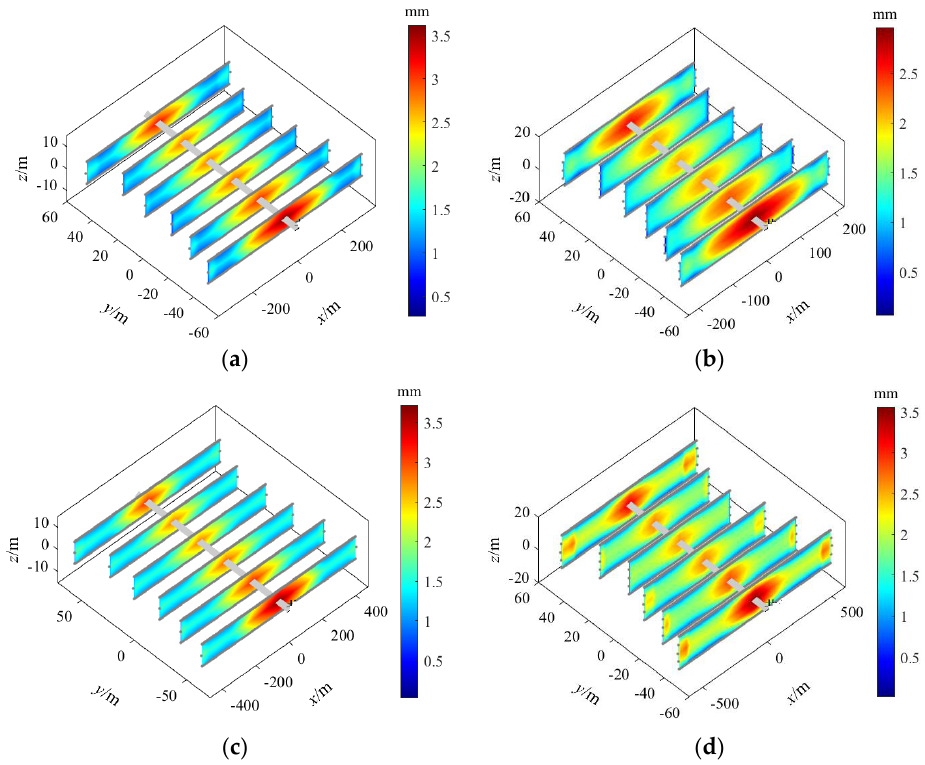
Figure 4. Multi - fracture propagation pattern under different reservoir thickness and interlayer